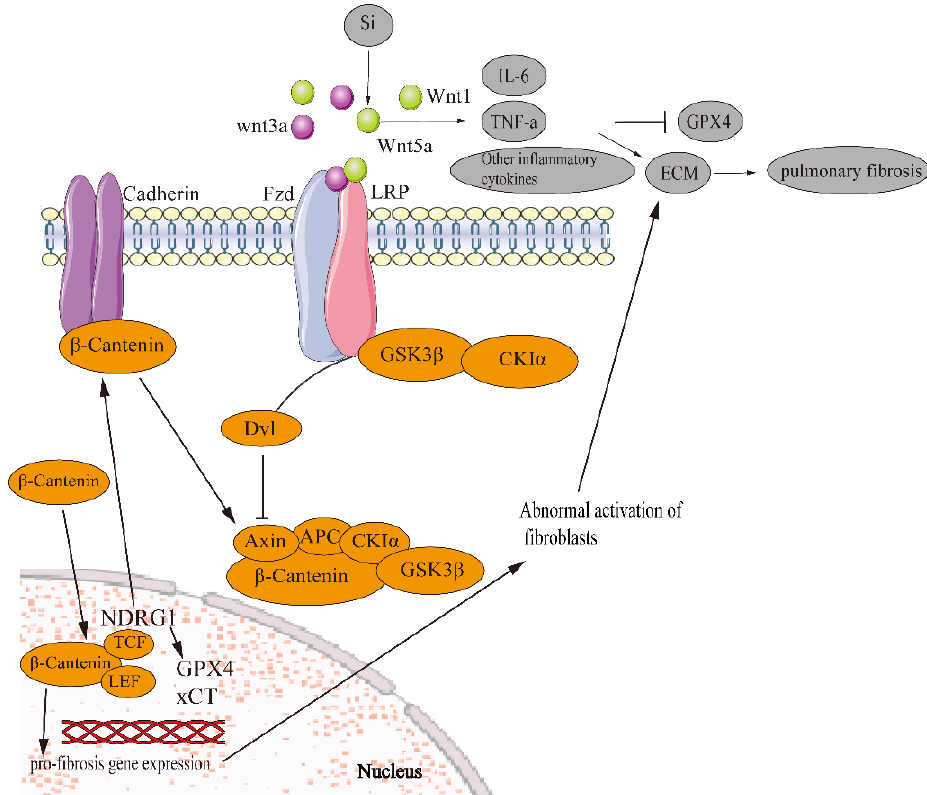
Figure 3. Ferroptosis regulates EMT in pulmonary fibrosis via the Wnt signaling pathway. β -catenin forms a destructive complex with Axin, APC, CKI α and GSK3 β . β -catenin is phosphorylated by GSK3 β and CKI α , resulting in β -Catenin degradation by ubiquitination. Undegraded β -catenin accumulates in the cytoplasm and is transferred to the nucleus. β -catenin binds to TCF/LEF, which promotes transcription of downstream pro-fibrosis genes, leading to abnormal activation of fibroblasts and ECM deposition. Silicon stimulation can significantly activate Wnt5a and other inflammatory signaling pathways, release IL-6, TNF- α and other inflammatory factors, inhibit the expression of GPX4 protein and promote ferroptosis. When Wnt ligands are secreted and bind to the FZD receptor and LRP coreceptor, the LRP receptor is phosphorylated by CK1 α and GSK3 β . The phosphorylated LRP receptor recruits Dvl protein into the plasma membrane, and Dvl aggregates and is activated. A Dvl polymer destroys and inactivates the complex. Dvl-1 inhibits axin-mediated GSK3 β -dependent phosphorylation of β -catenin, leading to stabilization and accumulation of β -catenin, which is then translocated into the nucleus. E-cadherin also inhibits β -catenin by forming the E-cadherin/ β - catenin complex to prevent nuclear translocation of β -catenin. The NDRG1 gene promotes the formation of the E-cadherin/ β -catenin adhesion complex on the cell membrane to prevent β -catenin nuclear